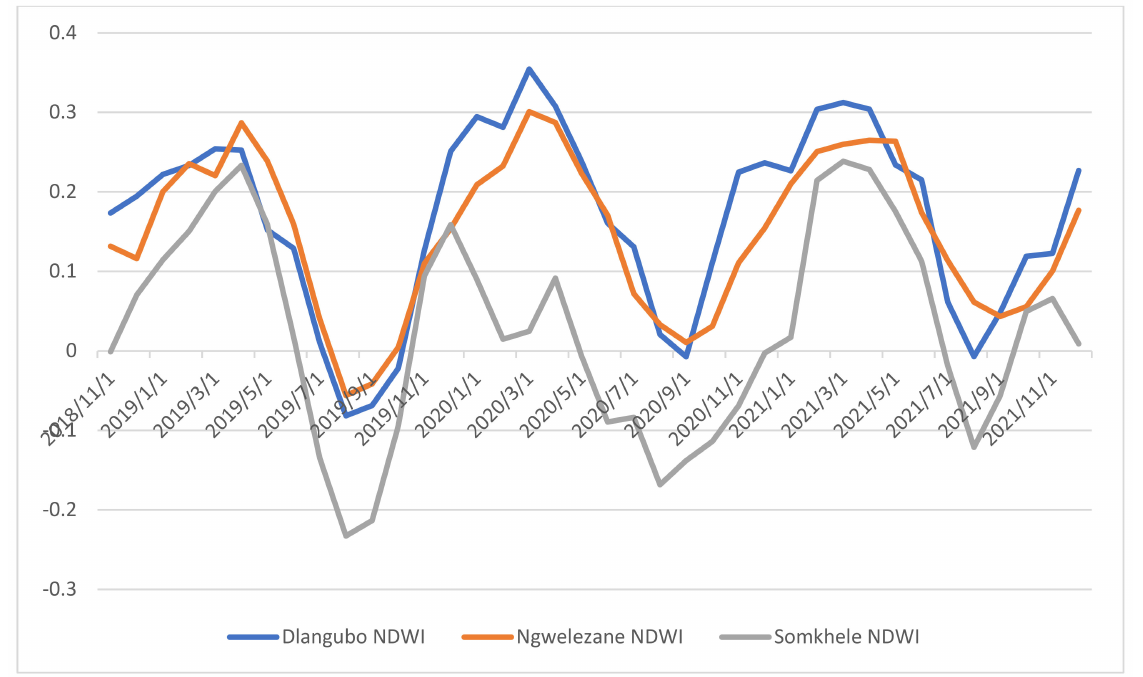
Figure 4. Time series of the Normalized Difference Water Index (NDWI) in the Dlangubo, Ng- welezane, and Somkhele (Mtubatuba) sites from 19 December 2018 to 19 December 2021. As NDWI declined, the greenness and water status of the vegetation declined. Values below 0 show very poor vegetation [35], and it principally occurred at the Somkhele site and in the second season. Jan = January, Mar = March, Jul = July, Sep = September, and Nov =